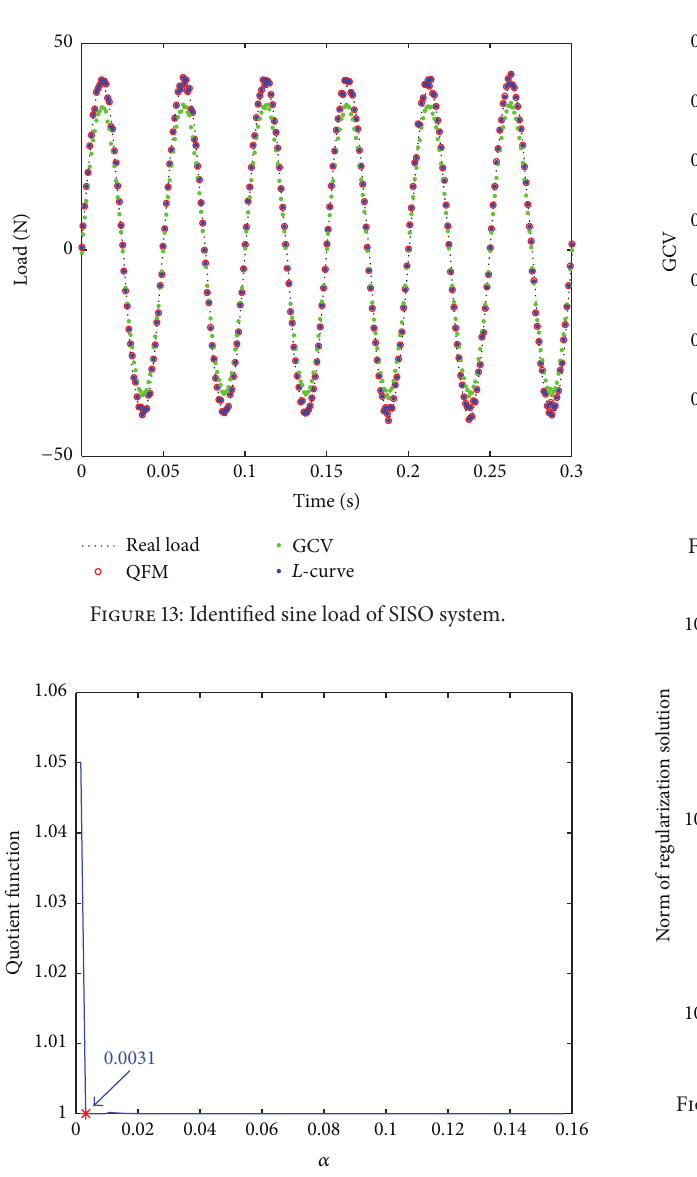
Figure 14: QF for load identification of MIMO system.